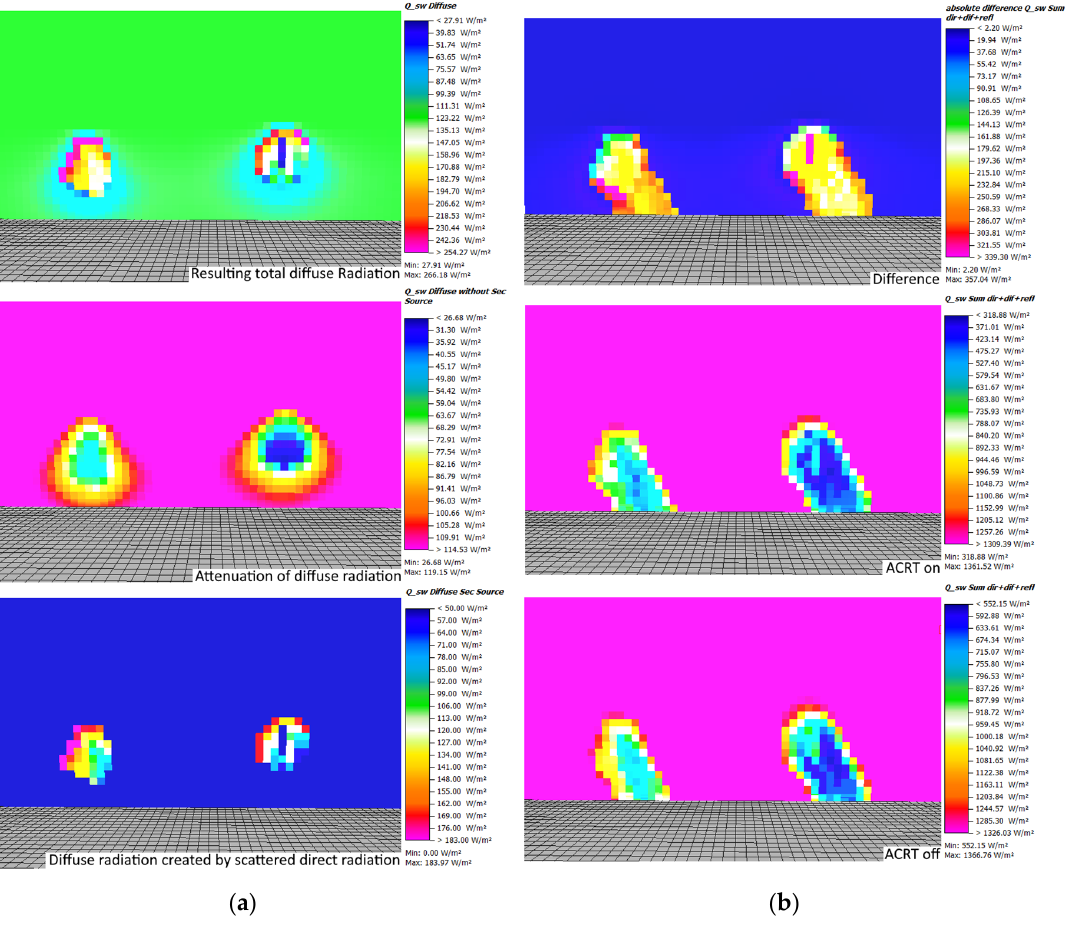
Figure 7. Model output at noon time (sun position: 164.4° azimuthal and 58.3° height angle, view direction: West) for the L-Tree (left) and Parametric-Tree (right): Diffuse shortwave radiation patterns with the ACRT module ( a ); sum of all shortwave radiation fluxes (direct, diffuse, and reflected shortwave radiation) with and without the ACRT module ( b ).